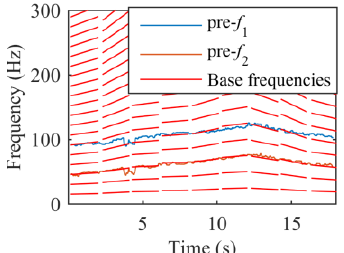
Figure 14. Inner race fault case: illustration of the constructed frequencies of bases of FMLT.